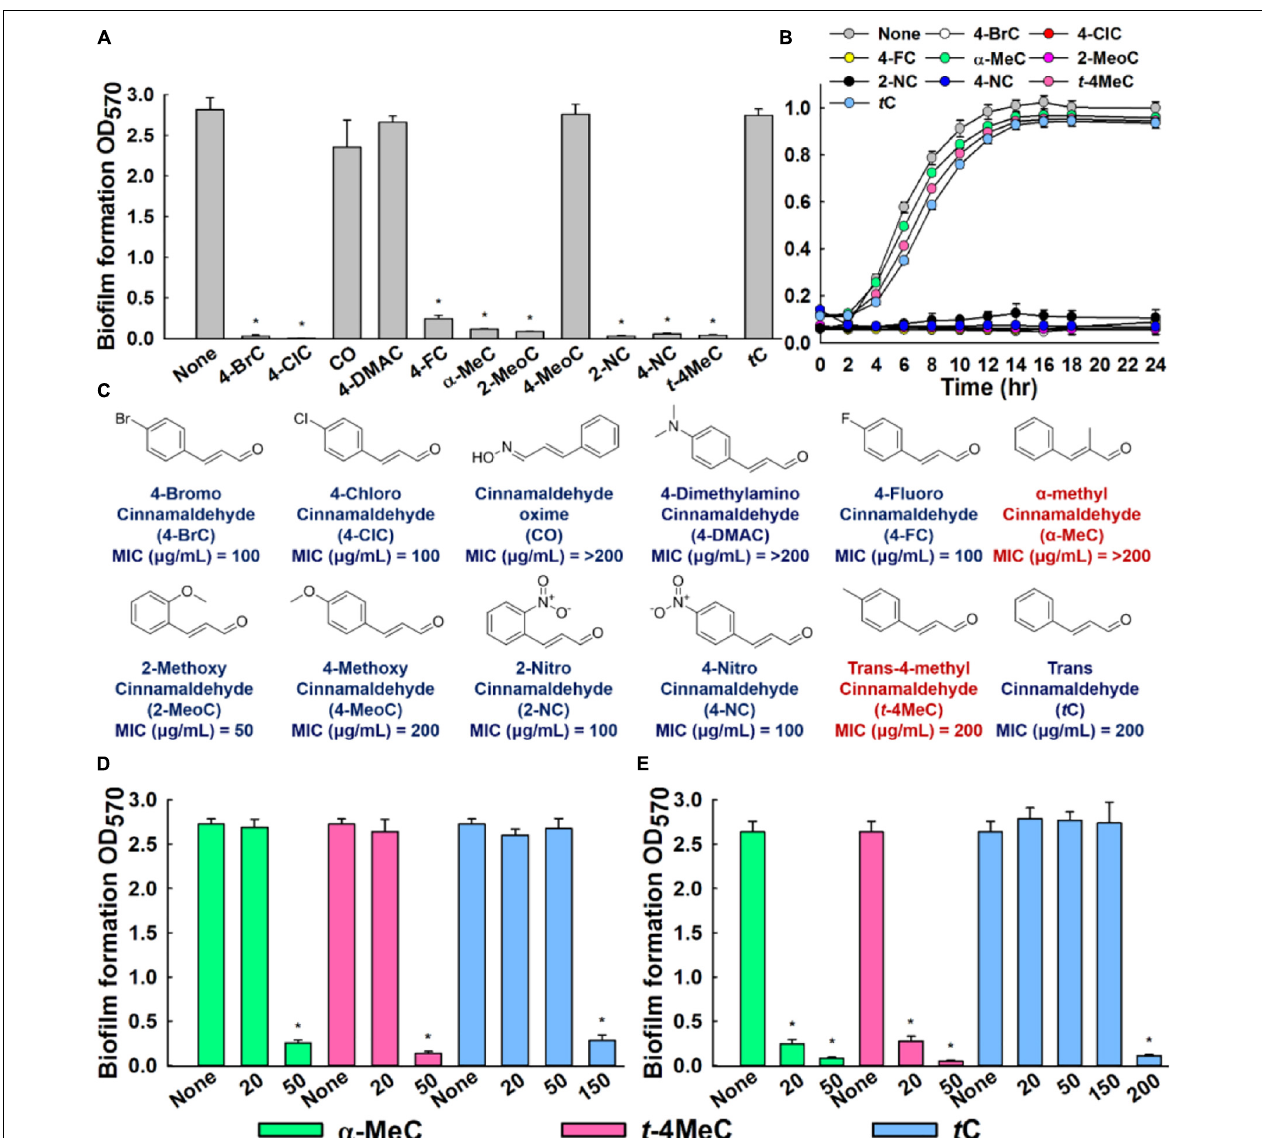
FIGURE 1 | In vitro antibiofilm activities of cinnamaldehyde analogs against C. albicans . Influences of eleven cinnamaldehyde analogs and trans- cinnamaldehyde ( t C) on biofilm formation by the C. albicans DAY185 at 100 µ g/mL (A) , C. albicans DAY185 cell growth was investigated in the presence of the eight antibiofilm cinnamaldehyde analogs and the trans -cinnamaldehyde control at 100 µ g/mL (B) , Chemical structures and MIC (C) . The antibiofilm activities of α -methyl cinnamaldehyde ( α -MeC) and trans- 4-methyl cinnamaldehyde ( t -4MeC) at 20 and 50 µ g/mL, and trans -cinnamaldehyde ( t C) at 20–200 µ g/mL against C. albicans DAY185 (D) and C. albicans ATCC 10231 (E) . Error bars indicate standard deviations. * P < 0.05 vs. non-treated controls